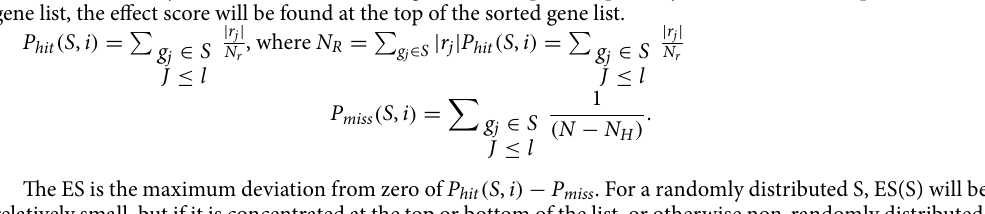
distributed in the sorted gene list or the whole genes in the pathway does not show differential expression, the maximum can always find at the bottom; if the genes in the specified pathway distributed at the top of the sorted gene list, the effect score will be found at the top of the sorted gene list.